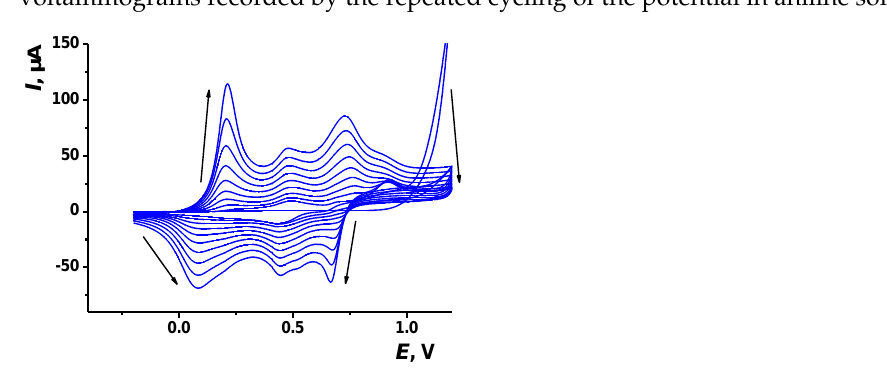
Figure 2. Cyclic voltammograms recorded on GCE in 0.2 M H 2 SO 4 containing 0.07 M aniline, scan rate 50 mV/s. Arrows indicate changes in the peaks with an increasing number of cycles.